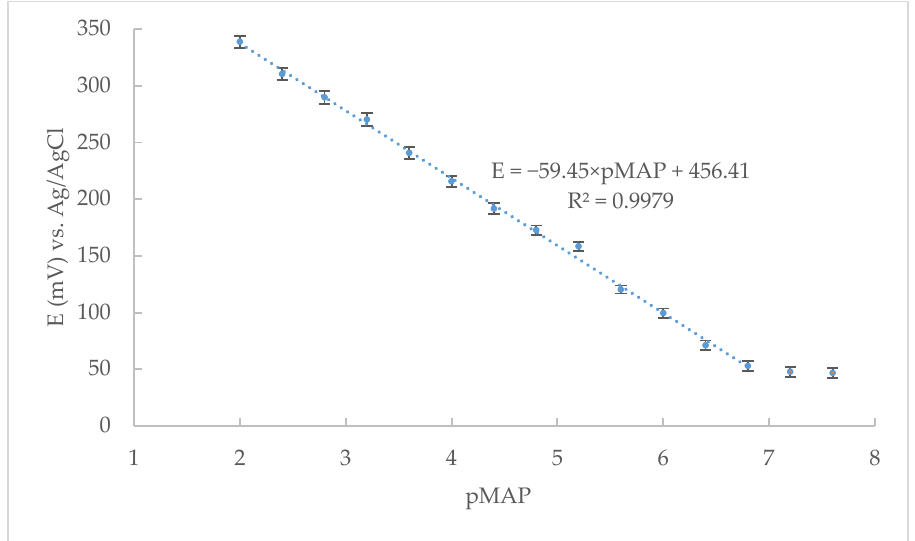
Figure 2. Calibration curve of the optimized CPE for maprotiline potentiometric determination (eleven replicates).